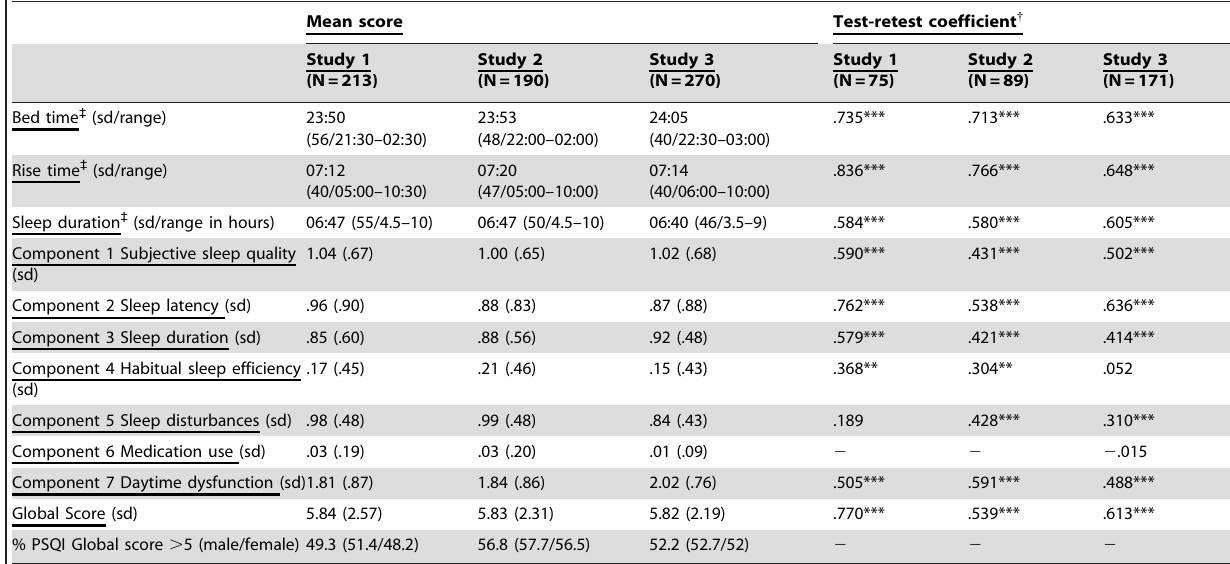
Table 3. Descriptive statistics for each PSQI component for each